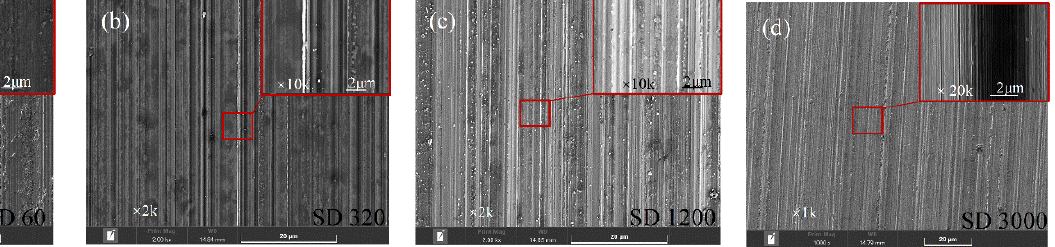
Figure 3. Morphologies of the BLHS Si surfaces fabricated by ( a ) SD 60, ( b ) SD320, ( c ) SD1200, and ( d ) SD3000 diamond grinding wheels. ( d ) SD3000 diamond grinding